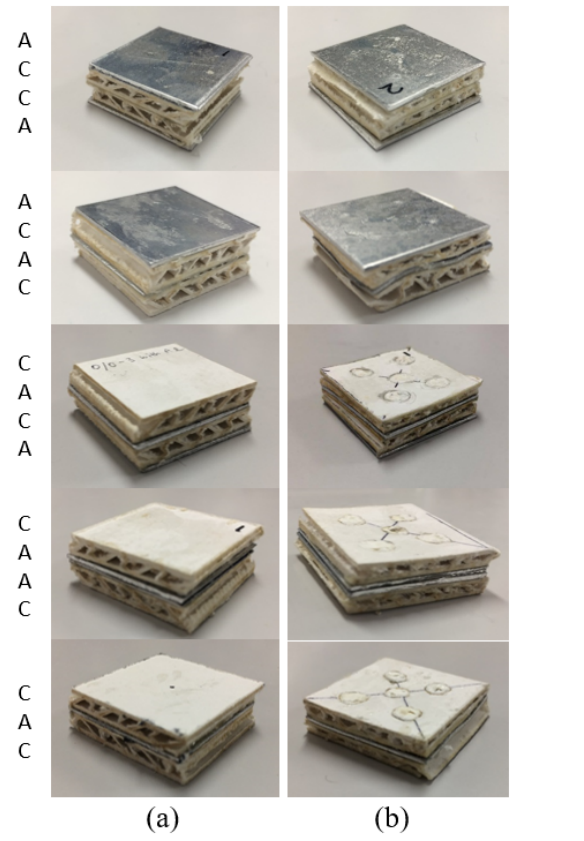
Figure 10: Images of cardboard and aluminum panel configurations after compression testing: (a) panels without rods; (b) panels with